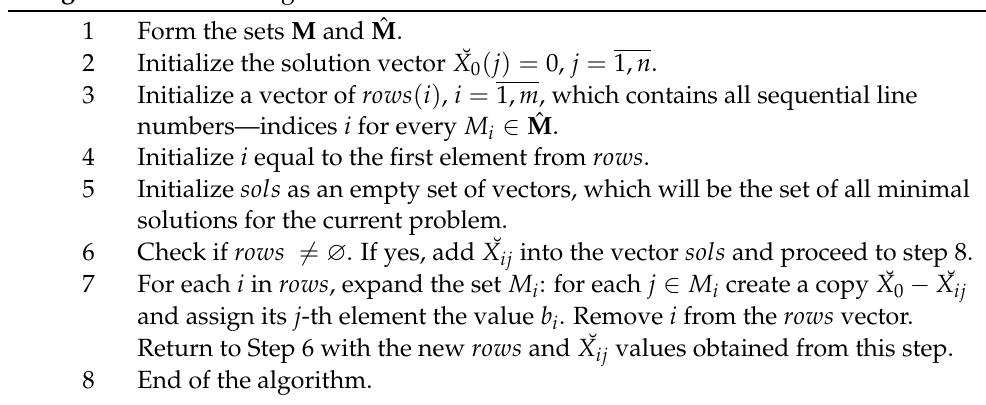
Algorithm 2: Obtaining lower solutions from ˆ M